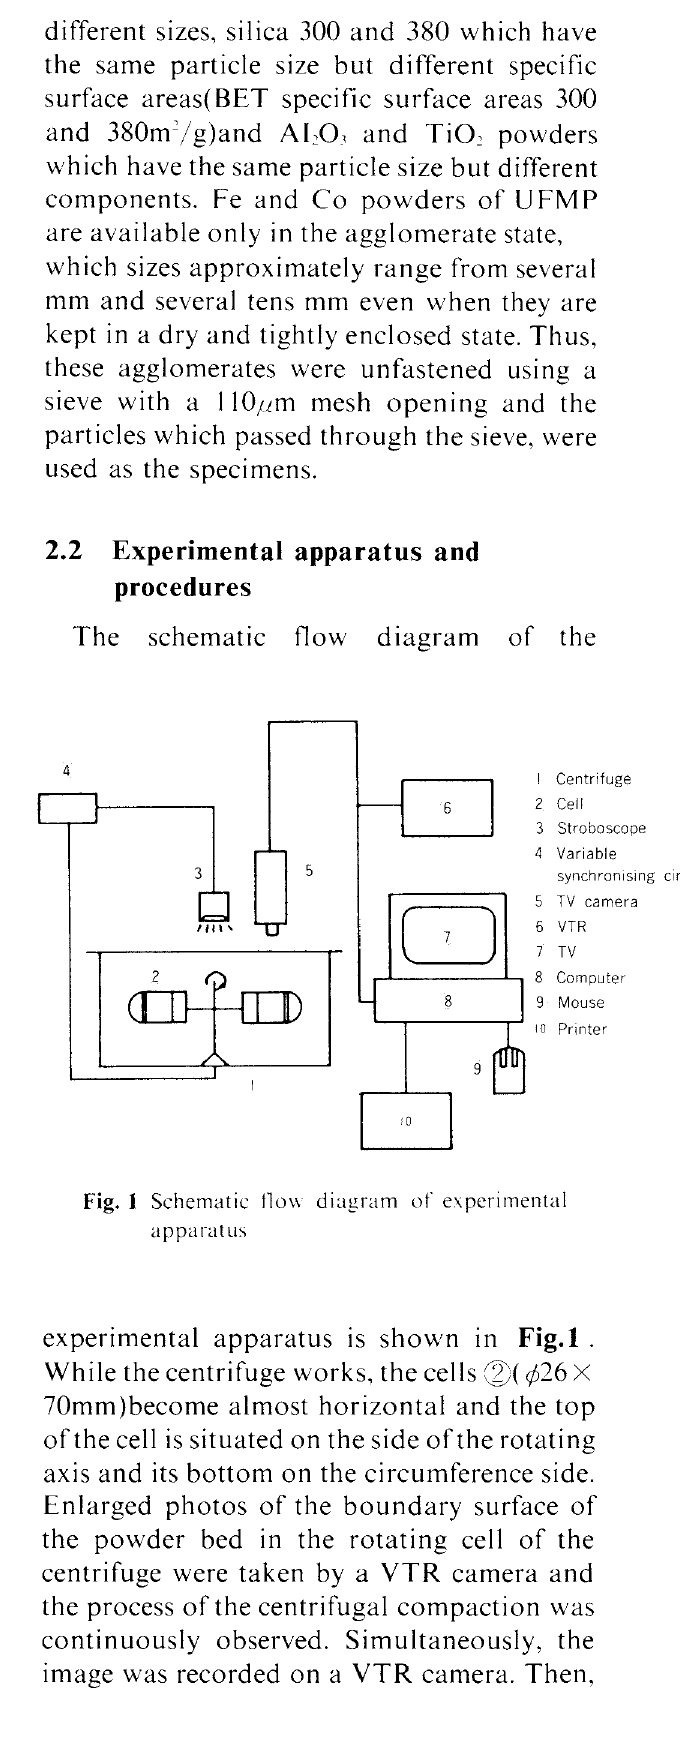
Fig. 1 Schematic tlm\ diagram of experimental apparatus